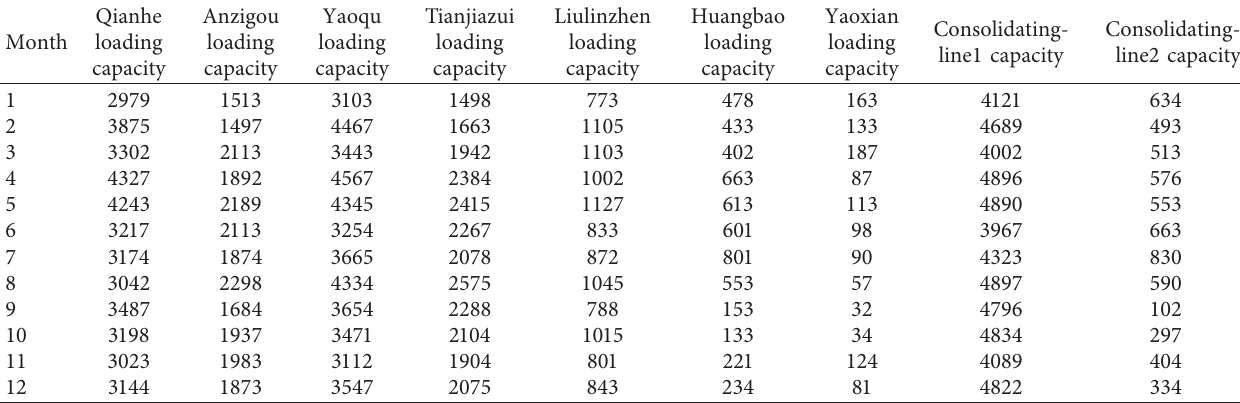
Figure 4: Simplified floor plan of the Tongchuan Depot. Table 1: Initial statistics of the “consolidation” system of the Tongchuan Train Depot in each month in 2017.